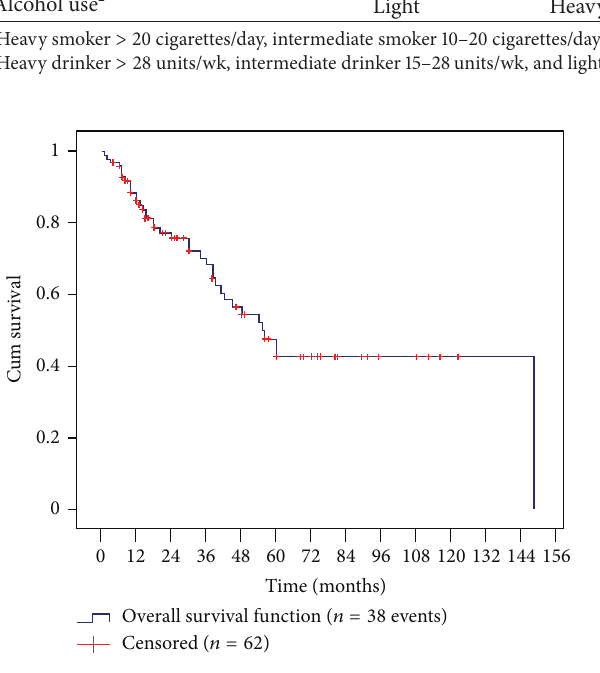
Figure 3: Kaplan-Meier analysis plotting overall disease-free sur- vival.